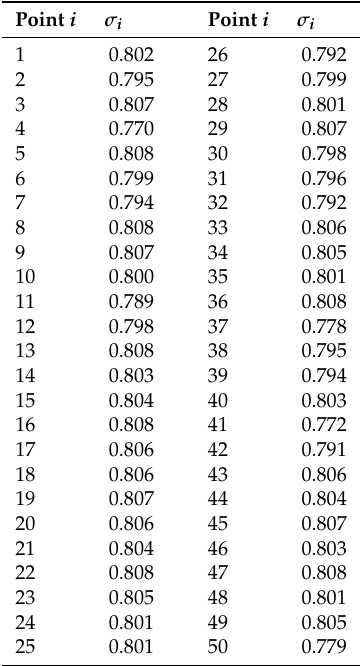
Table 3. Pointwise precision σ xi = σ yi = σ zi = σ i for each point P i